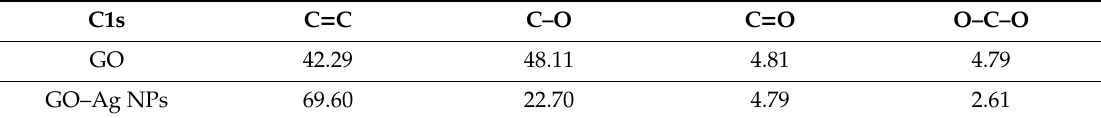
Table 1. Functional group percentage (%) of chemical bonds presents in GO and GO–Ag NPs as determined from C1s deconvolution of the corresponding high-resolution XPS spectra C1s